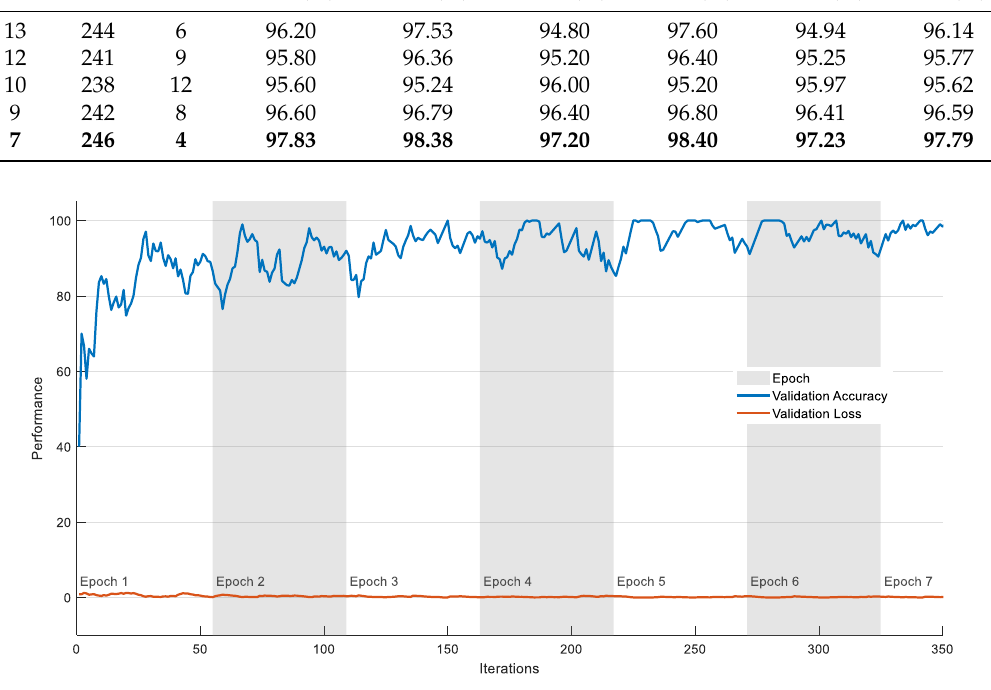
Figure 10. Training performance of the VGG19 with SVM-RBF for lung CT image slices.